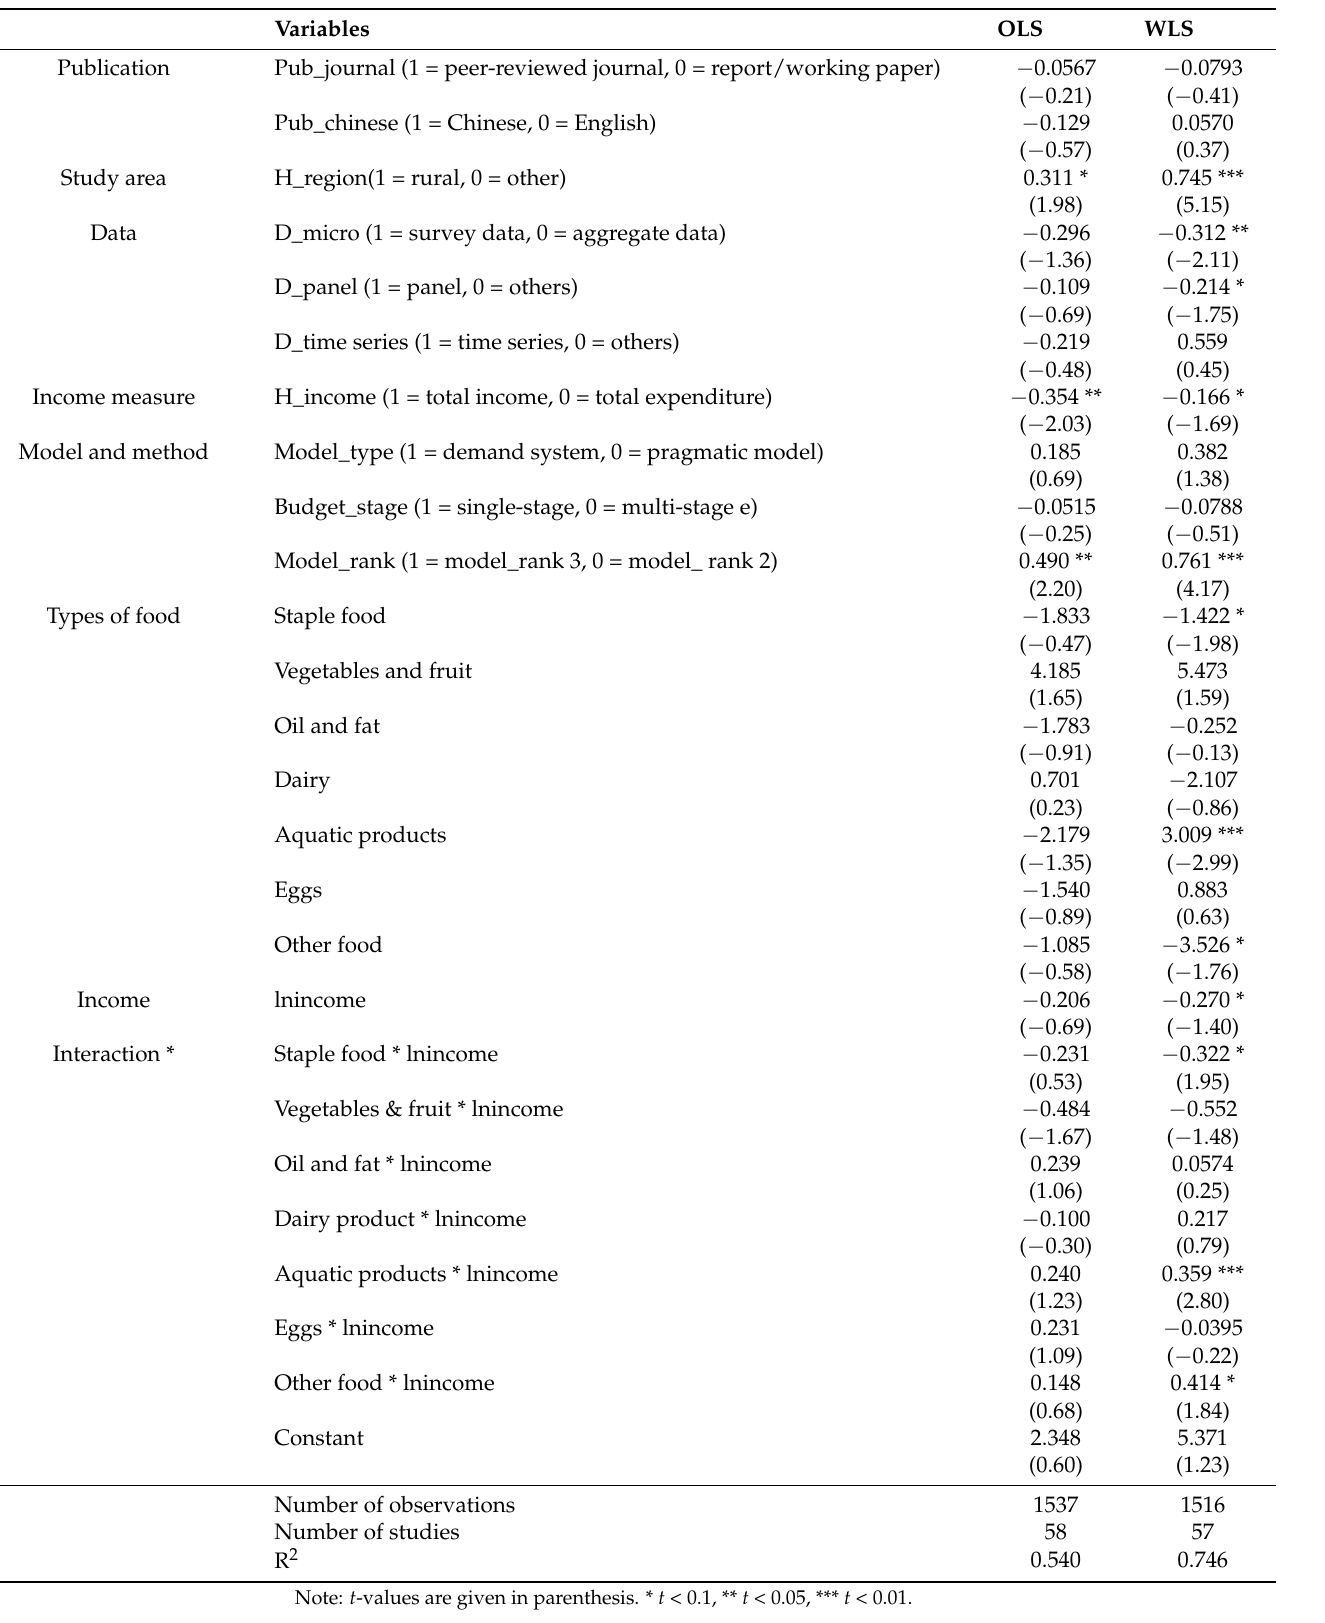
Table 4. Results from the meta-regressions of food–income